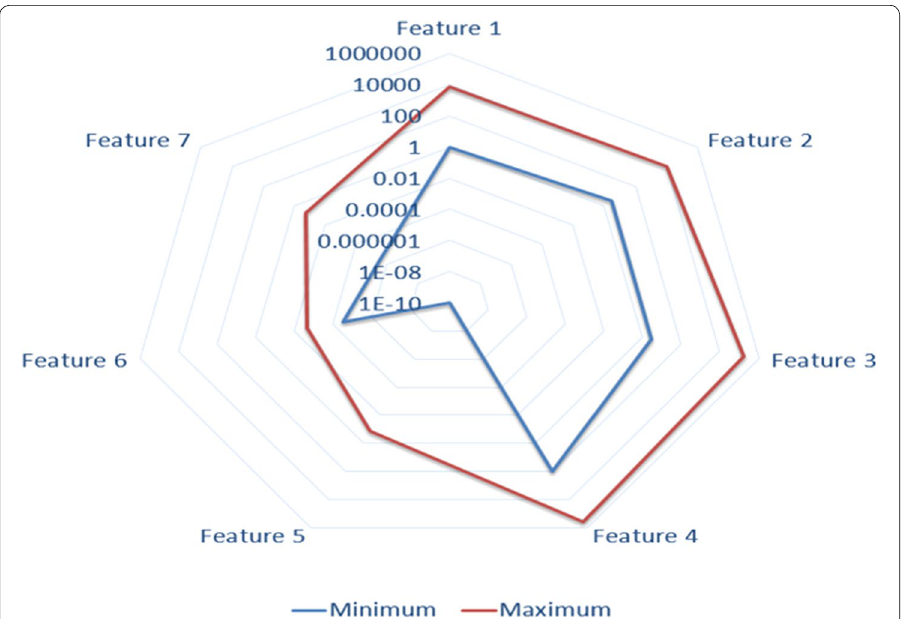
Fig. 8 Varying range of graph-based features across CTU-13